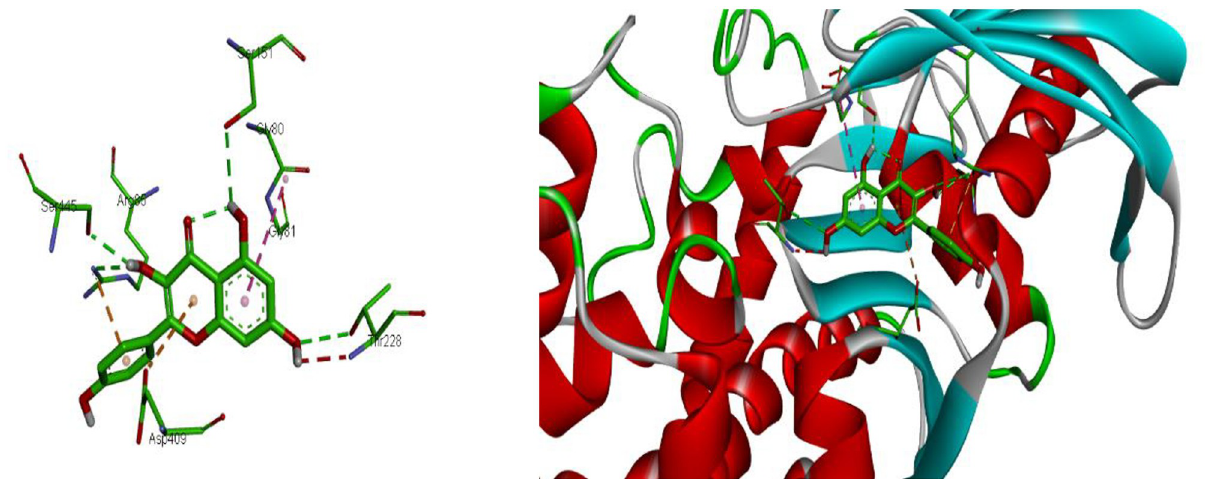
Fig 8. 2D and 3D representation of the interaction of kaempferol with human glucokinase PDB ID: 1V4S. https://doi.org/10.6084/m9.figshare. 21828957.v1.